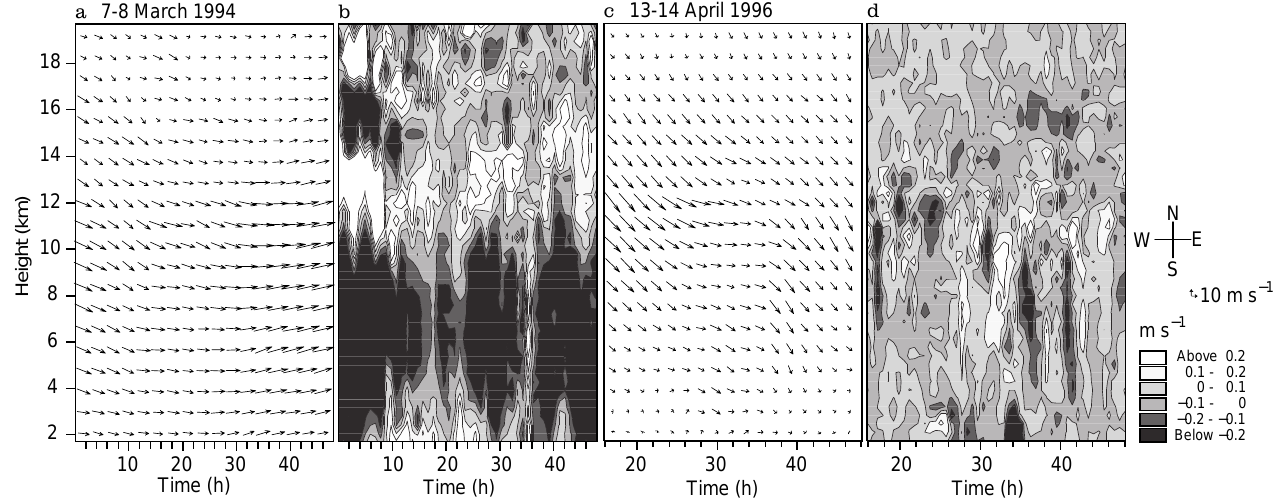
Fig. 3a–d. Height-time plots of background wind vectors and vertical velocity contours for the two datasets used in Figs. 1 and